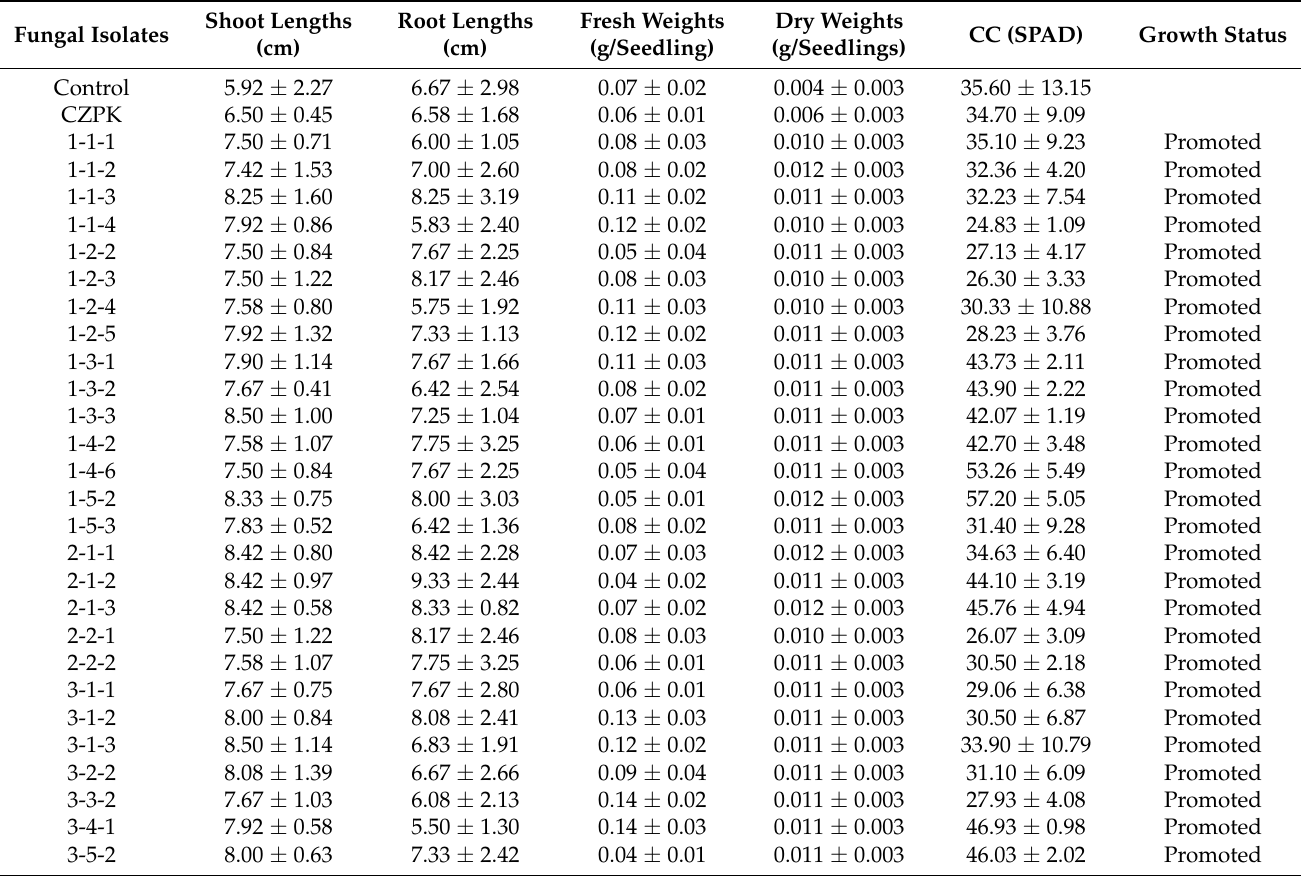
Table 1. Growth-promoting effect of culture filtrate of different endophytic fungal isolates on Waito- C